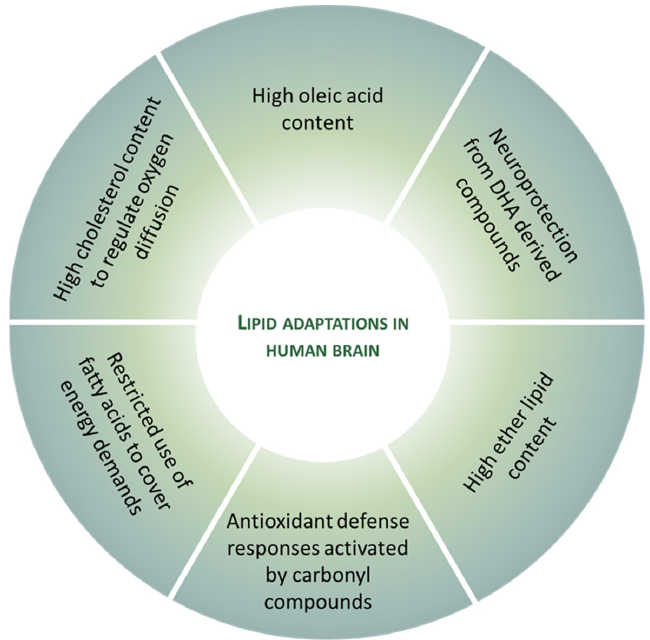
Figure 4. Lipid adaptations against oxidative challenge in the healthy human brain.